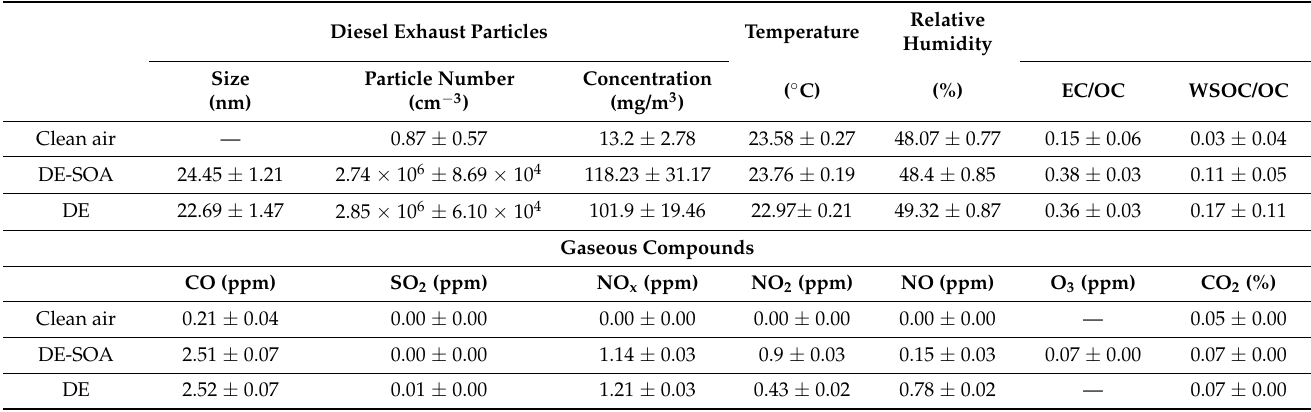
Table 3. Characteristics of diesel exhaust particles and gaseous compounds in exposure